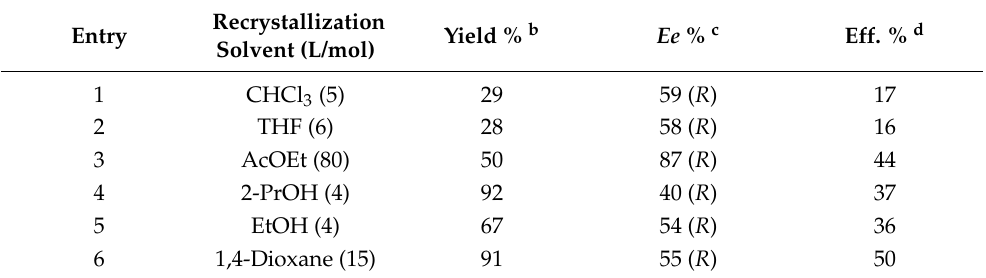
Table 5. Optical resolution of racemic 3-hydroxy-4-(4-chlorophenyl)butanoic acid ( rac - 2 ) with cinchonidine a .